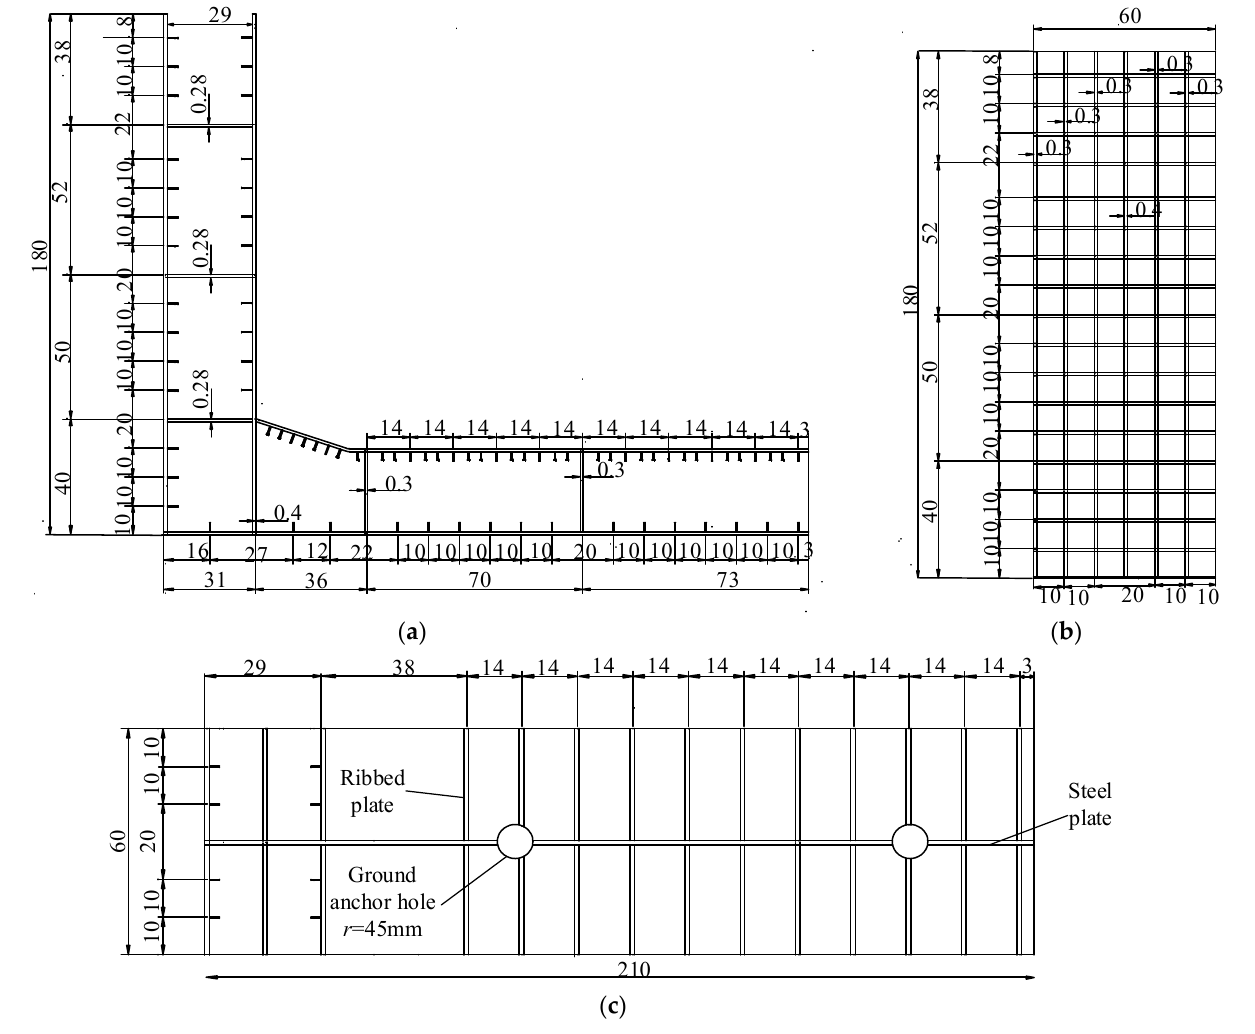
Figure 3. Design details of the T-shaped specimen (unit: cm). ( a ) Front view; ( b ) side view; ( c ) top view.